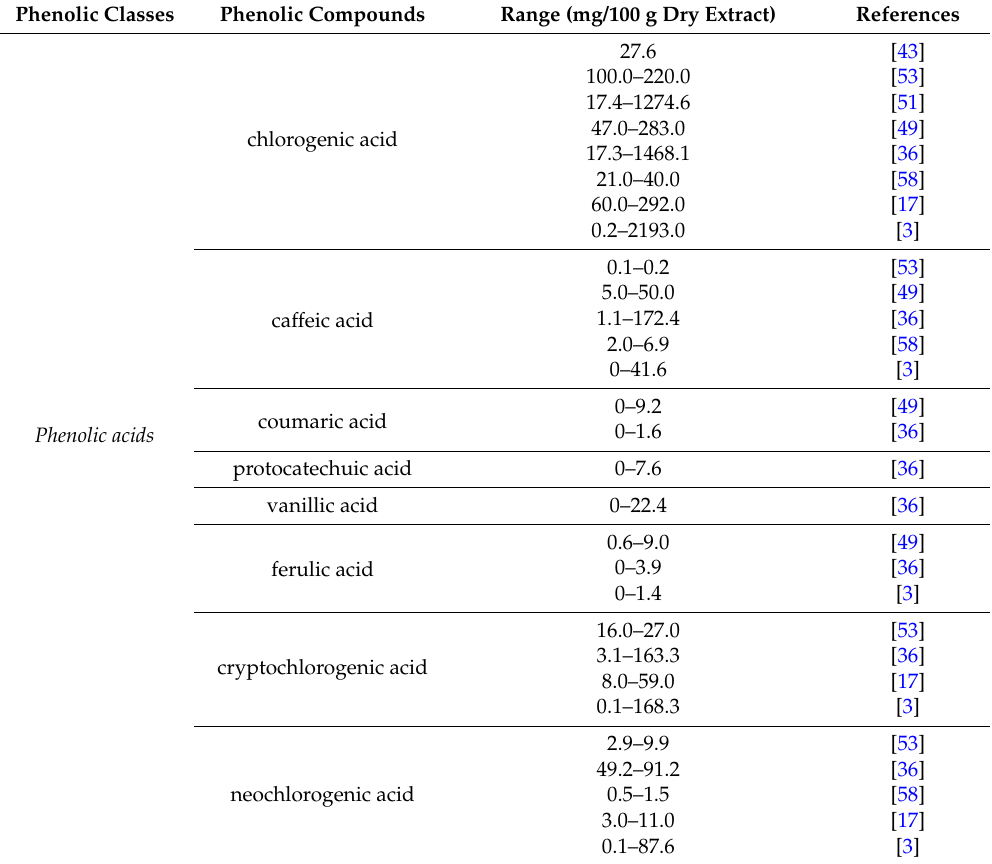
Table 1. Concentration levels of the main phenolic compounds in